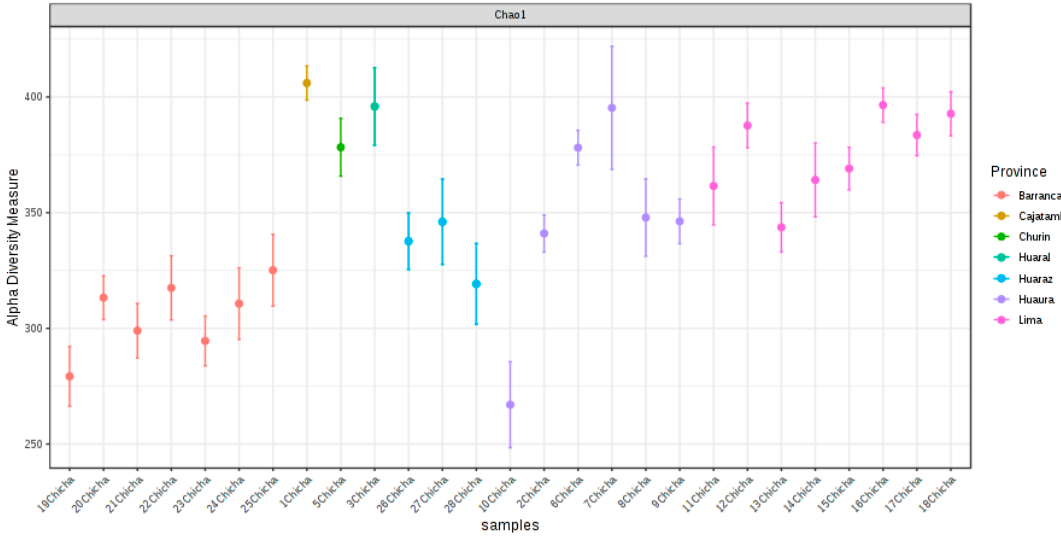
Figure 2. Plot of OTUs richness (Chao1) in all analyzed chicha samples. The Chao index estimate the total number of OTUs present in each chicha sample.